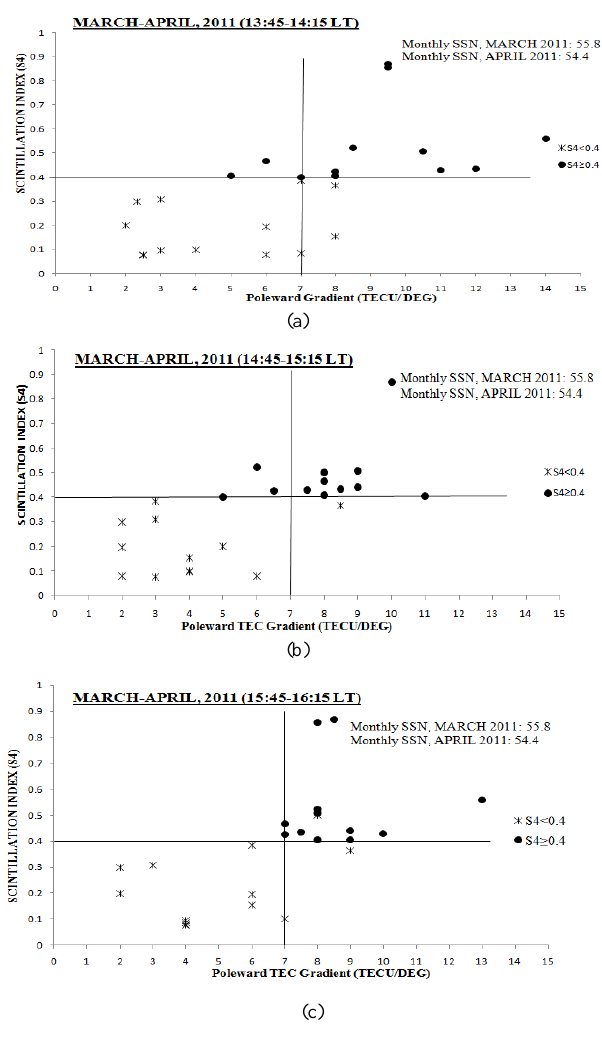
Figure 5 Fig. 5. (a–c) Correlation of poleward gradient of EIA calculated at Figure 4 Fig. 4. (a–c) Correlation of poleward gradient of EIA calculated at 14:00, 15:00 and 16:00LT, respectively, over subionospheric lati- 14:00, 15:00 and 16:00LT, respectively, over subionospheric lati- tude 24 ◦ –27 ◦ N and longitude swath 88.5 ◦ E on different days of tude 24 ◦ –27 ◦ N and longitude swath 88.5 ◦ E on different days of August–October 2011 with GPS scintillation ( S 4 ≥ 0.4) around the 23 March–30 April 2011 with GPS scintillation ( S 4 ≥ 0.4) around northern crest of the EIA (350km subionospheric swath 21.5 ◦ – the northern crest of the EIA (350km subionospheric swath 21.5 ◦ – 23.5 ◦ N, 87.5 ◦ –89.5 ◦ 23.5 ◦ N, 87.5 ◦ –89.5 ◦ E). Table 1. Position coordinates of four dual-frequency GPS receivers used in the campaigns.